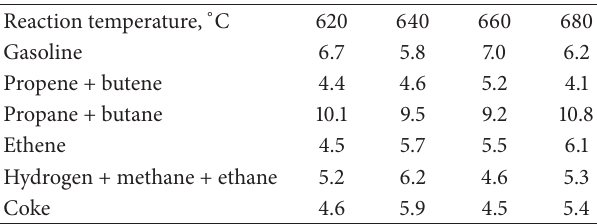
Table 6: Average relative error of lump yields at four tempera- tures, %.